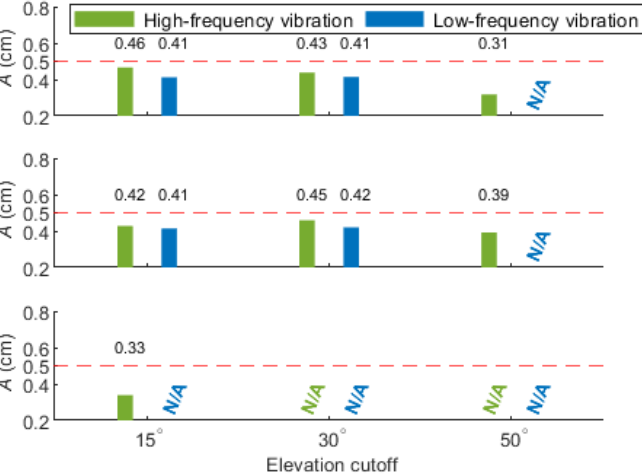
Figure 17. Amplitudes of the vibrational behaviors at levels of masking conditions. The five-constellation PCPPP with σ = ± 1 cm is adopted during the process. The top, middle and bottom panels refer to the E, N and U directions, respectively.